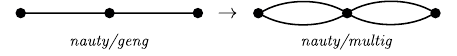
Figure 22: Simple quadratic vertices (left) give rise to bubble chains (right).